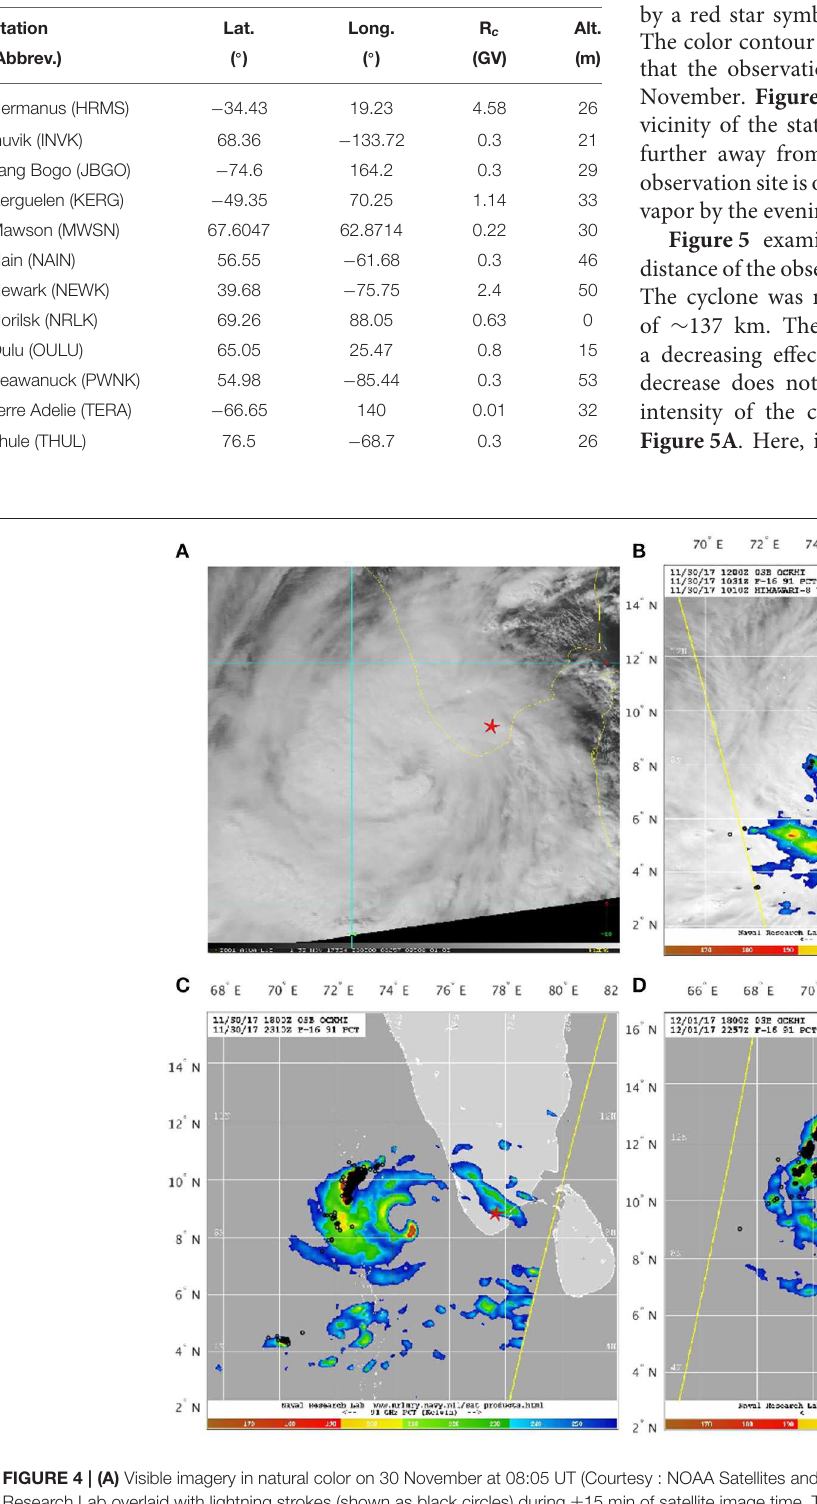
Frontiers in Earth Science |